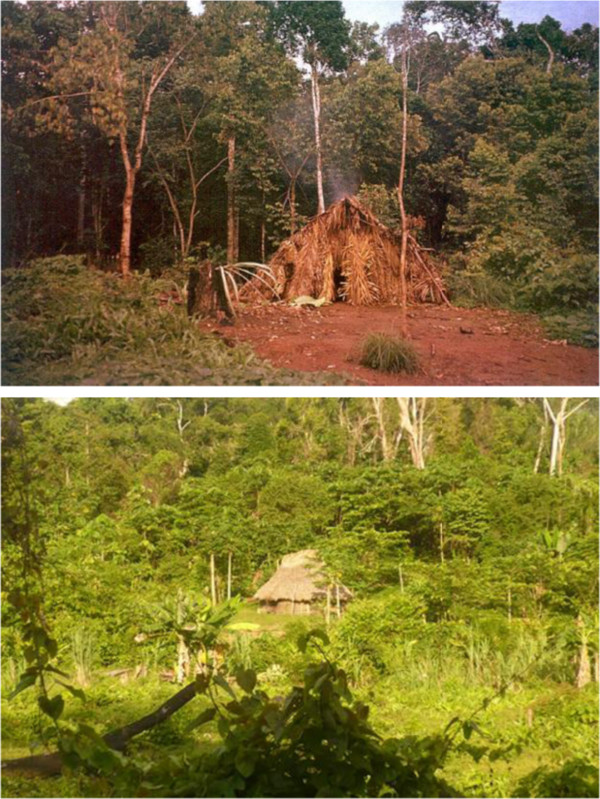
Jkujkyo bajaila&luwei, 1996, 2012.